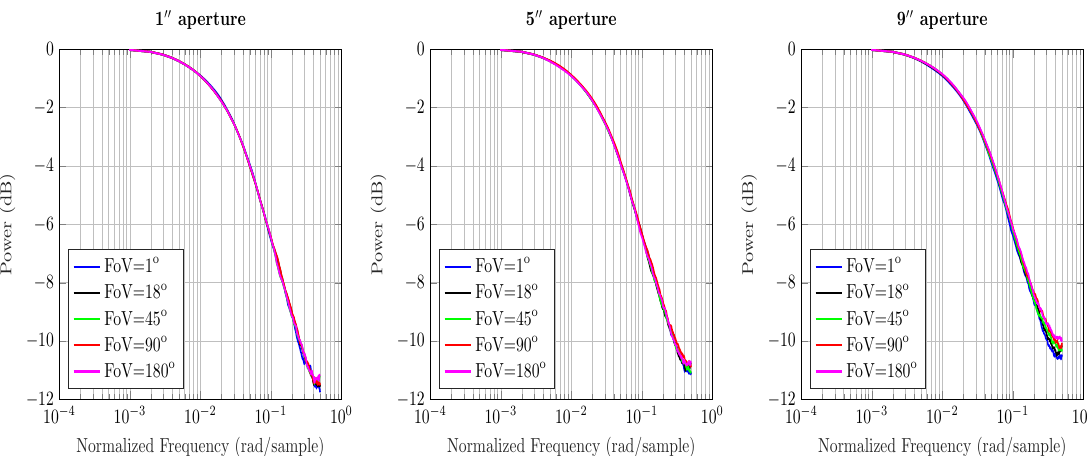
Figure 5. Comparison of the magnitude response of harbor water under various aperture sizes and FoVs for a 3 m LoS